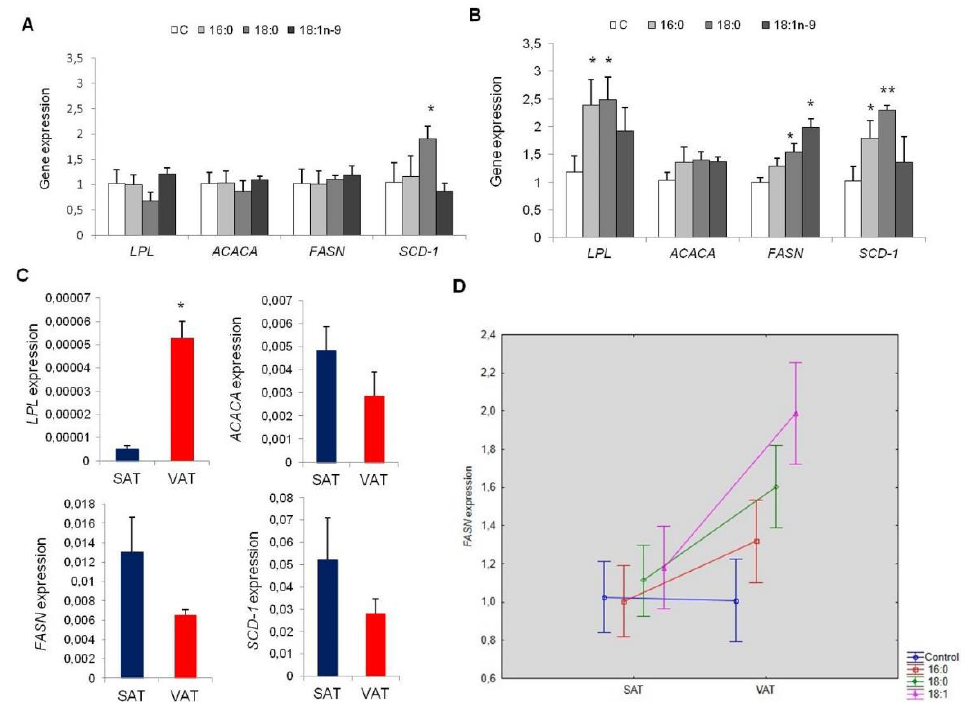
Figure 6. The expression of lipid metabolism genes in SAT and VAT adipocytes. Comparison of gene expression of control adipocytes and adipocytes differentiated with the excess of palmitic acid (16:0), stearic acid (18:0), and oleic acid (18:1n−9) obtained from SAT ( A ), VAT ( B ). The expression of lipid metabolism genes in adipocytes collected from SAT and VAT ( C ). The differential effect of fatty acid synthase ( FASN ) expression in cells collected from SAT and VAT differentiated with the excess of excess of palmitic acid (16:0), stearic acid (18:0) and oleic acid (18:1n−9) during adipogenesis (D ); * p < 0.05, ** p < 0.001.